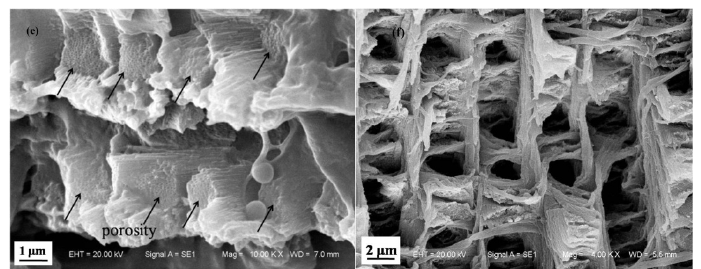
Figure 6. Layered microstructure of crosssections of Chinese mitten crab dactylopodite: ( a ) Exocuticle of dactylopodite, ( b ) endocuticle of dactylopodite, ( c ) Bouligand structure of endocuticle, ( d ) twisted filaments of fiber, ( e ) porosities between the fibers, ( f ) crossing frames.